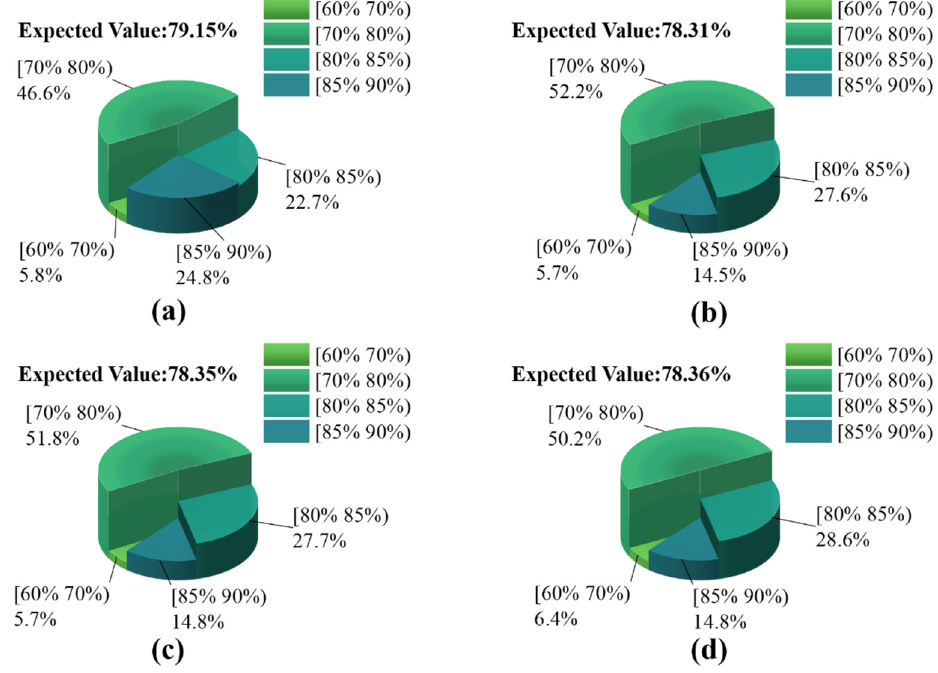
Figure 18. Efficiency distribution of front motor operating points. ( a ) RB strategy; ( b ) ECMS strategy; ( c ) MPC strategy; ( d ) H-EMS strategy.